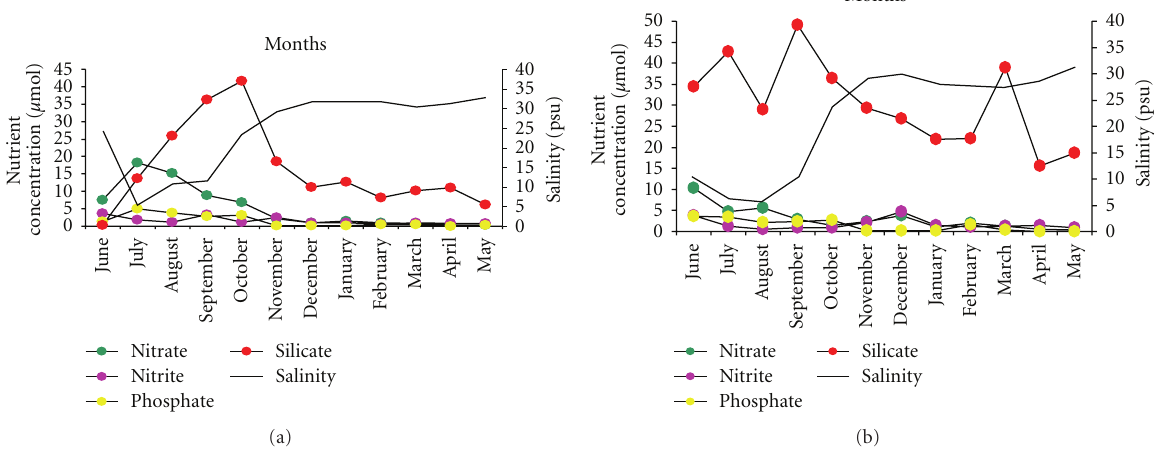
Figure 3: (a) Nutrients and salinity variations in Mandovi estuary. (b) Nutrients and salinity variations in Zuari estuary.